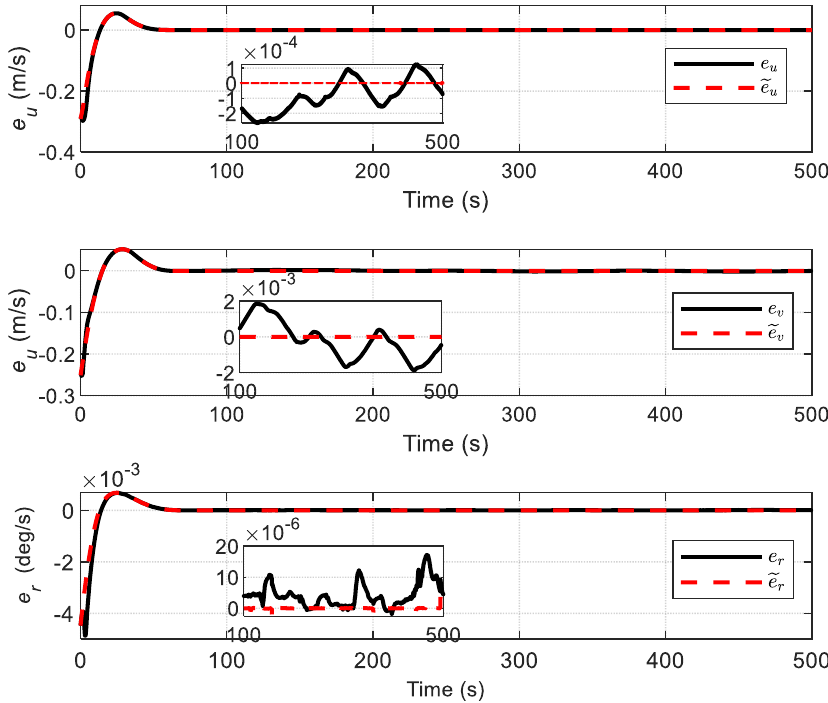
Figure 19. The velocity errors and the compensated velocity errors.